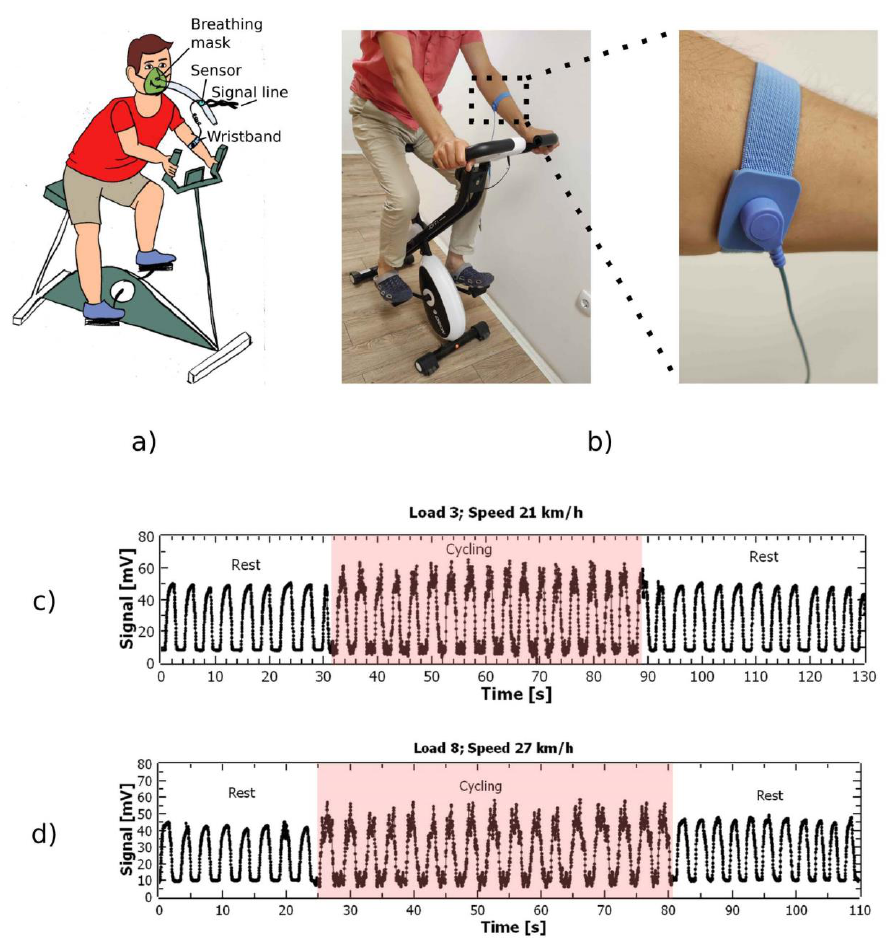
Figure 5. The use of the sensor with human body EM harvesting in the case of cycling exercise: ( a , b ) The volunteer with antistatic wrist strap carrying out cycling exercise; ( c ) The output of the sensor for load 3 on exercise bike and the speed of 21 km/h; ( d ) The output of the sensor for load 8 on exercise bike and the speed of 27 km/h. The load increased from 1 to 8. The pronounced noise during cycling is the consequence of the EM interference coming from the exercise bike, since the bike used EM-based load exerted on a driver.